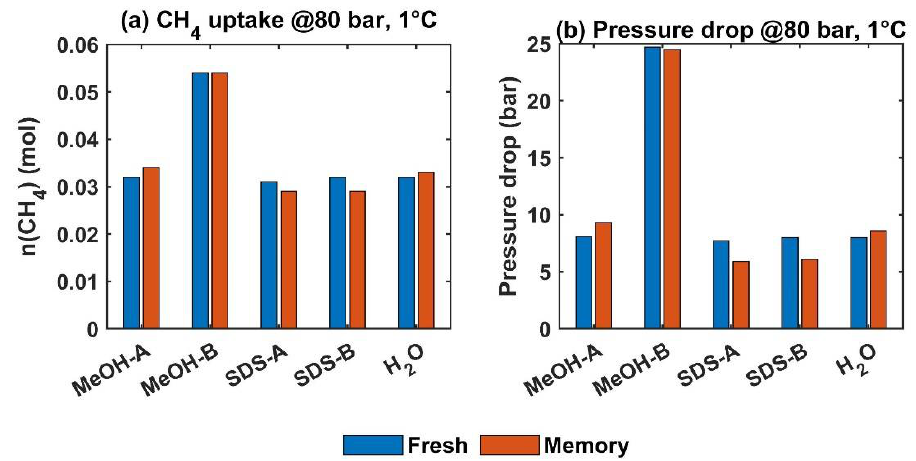
Figure 6. Total gas uptake during the isothermal temperature scheme in the presence of MeOH (A and B). The experimental temperature at 1 °C, ( a ) Total CH 4 gas uptake during isothermal under 80 bar, ( b ) Total pressure drop during Isothermal under P = 80 bar.